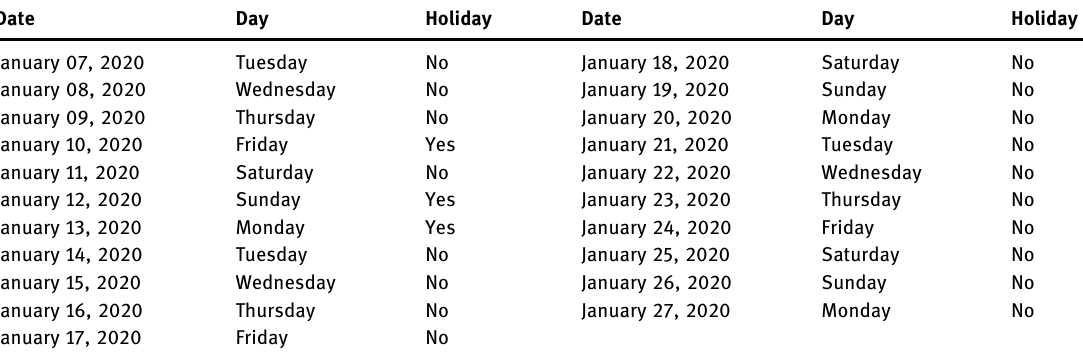
Table 1: Metadata of the